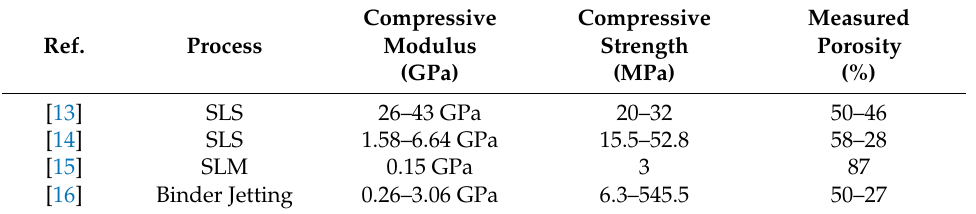
Table 1. AISI316L bone scaffolds mechanical properties found in the literature. Ref. Process